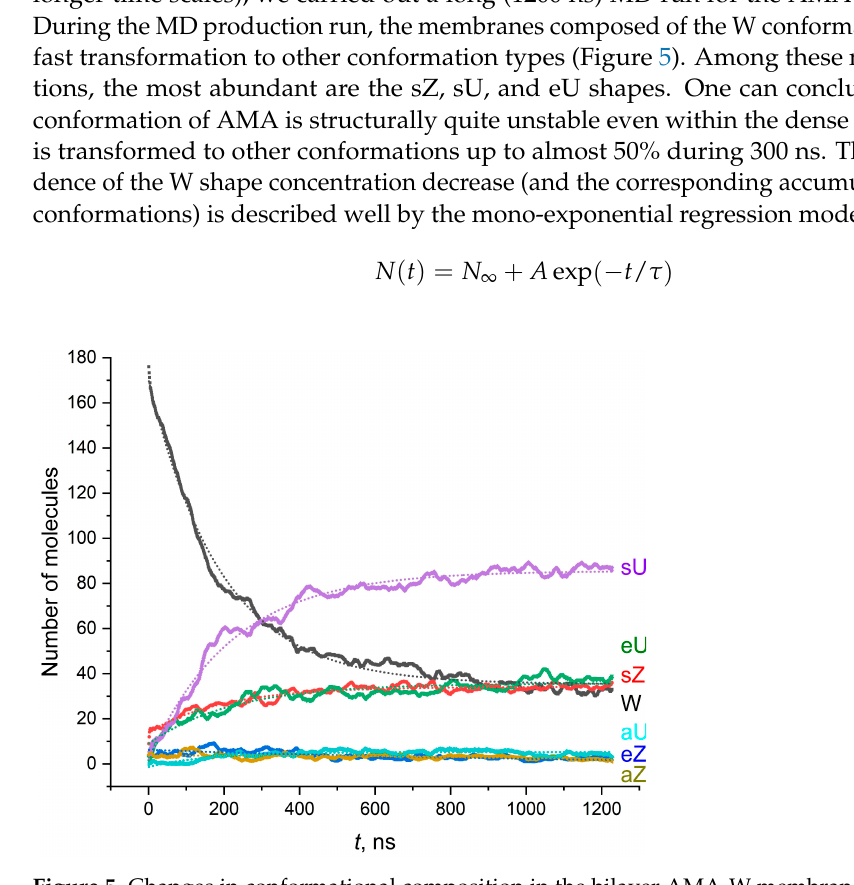
Table 1. Kinetic characteristics of the conformational transformations in the AMA-W system during 1200 ns of NPT MD. Most Abundant Conformations * W sZ eU sU aU Final number of molecules 𝑁 (cid:2869)(cid:2870)(cid:2868)(cid:2868) 33 36 38 87 3 Equilibrium number of molecules 𝑁 (cid:2998)